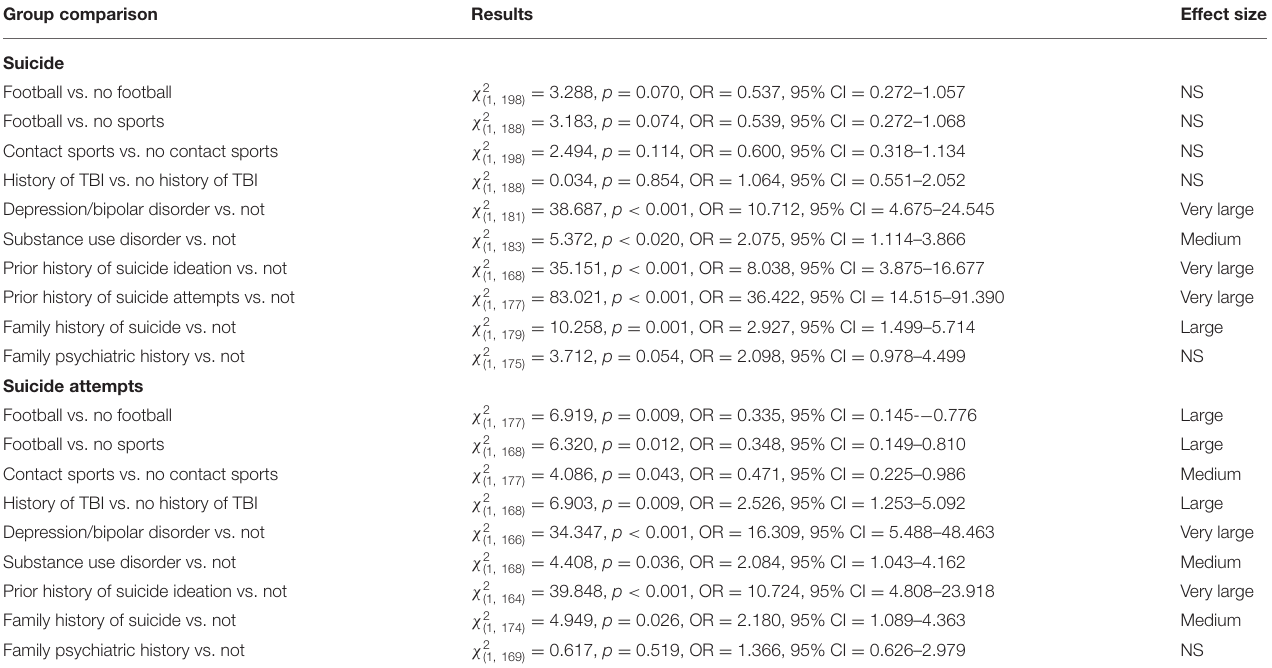
TABLE 2 | Comparing binary subgroups on proportions with suicide as a manner of death and with a lifetime history of suicide attempts. Group